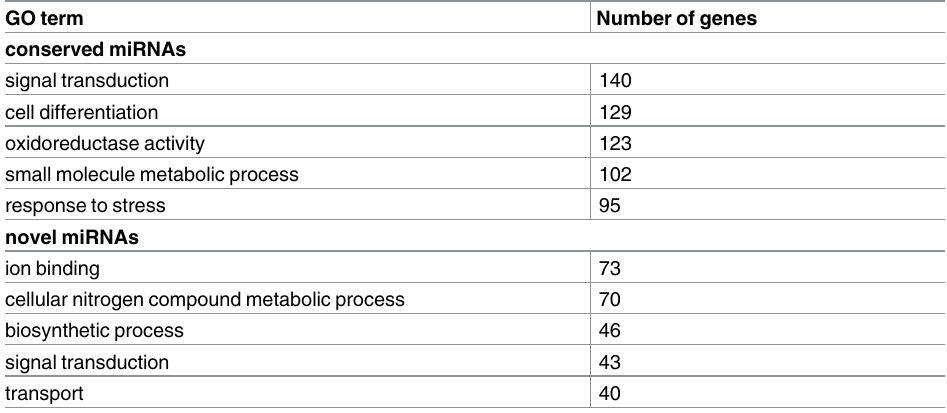
Table 2. Number of conserved and novel miRNAs target genes in the top 5 ranked GO